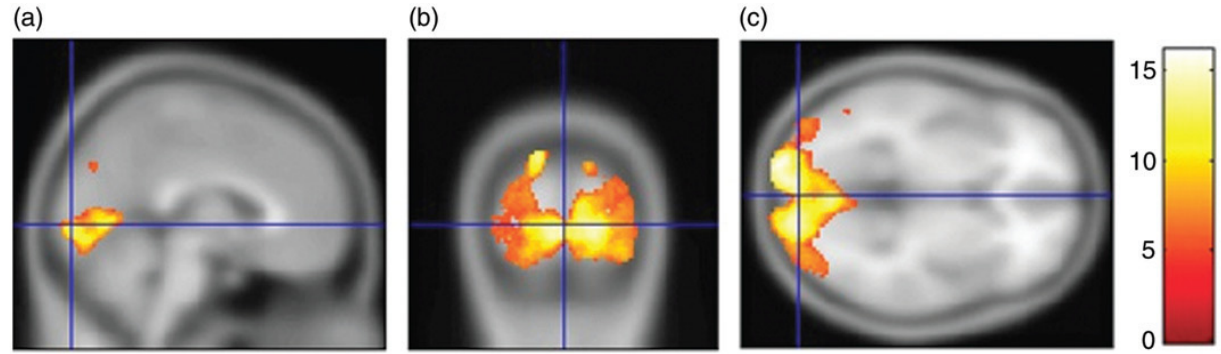
Fig. 1. Brain visual centre activity in a healthy 50-year-old woman. VARE: 1.0, VALE: 1.0 naturally. Sagittal (a), coronal (b) and transverse sections (c) show normal fMRI values of 6 815 voxels after simultaneous stimulation of both eyes (ref. 6 ).